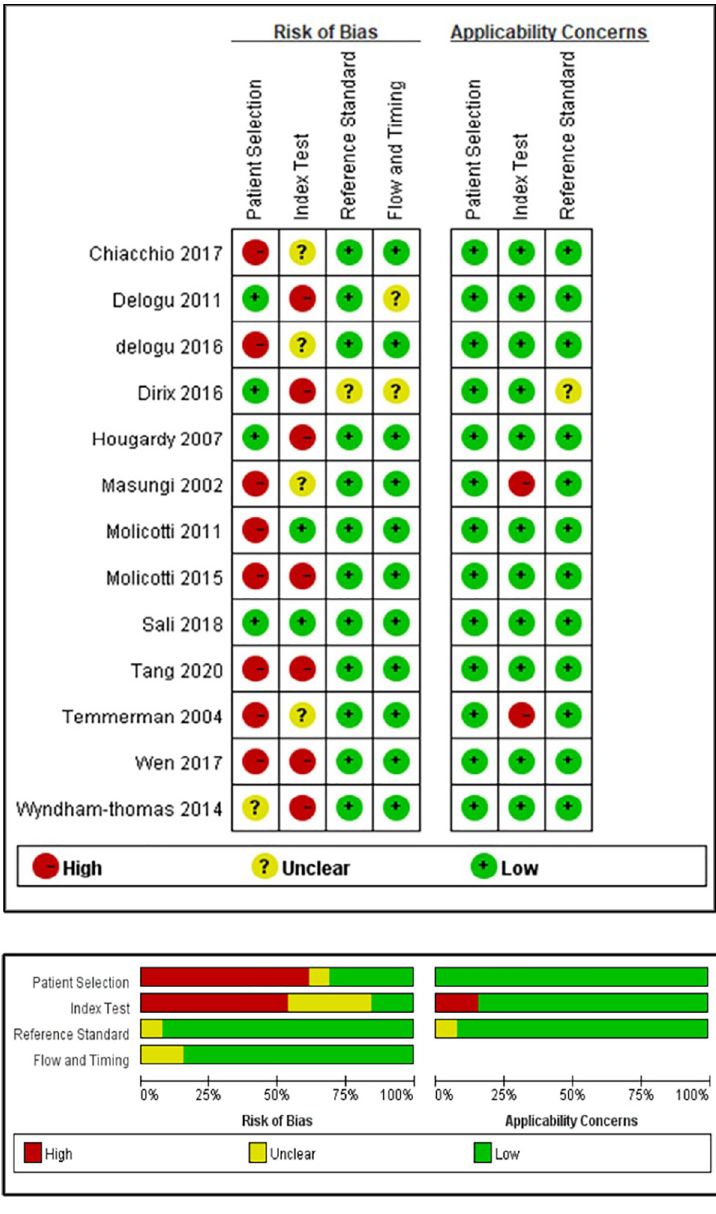
Fig 2. Summary of articles included regarding the risk of bias and applicability